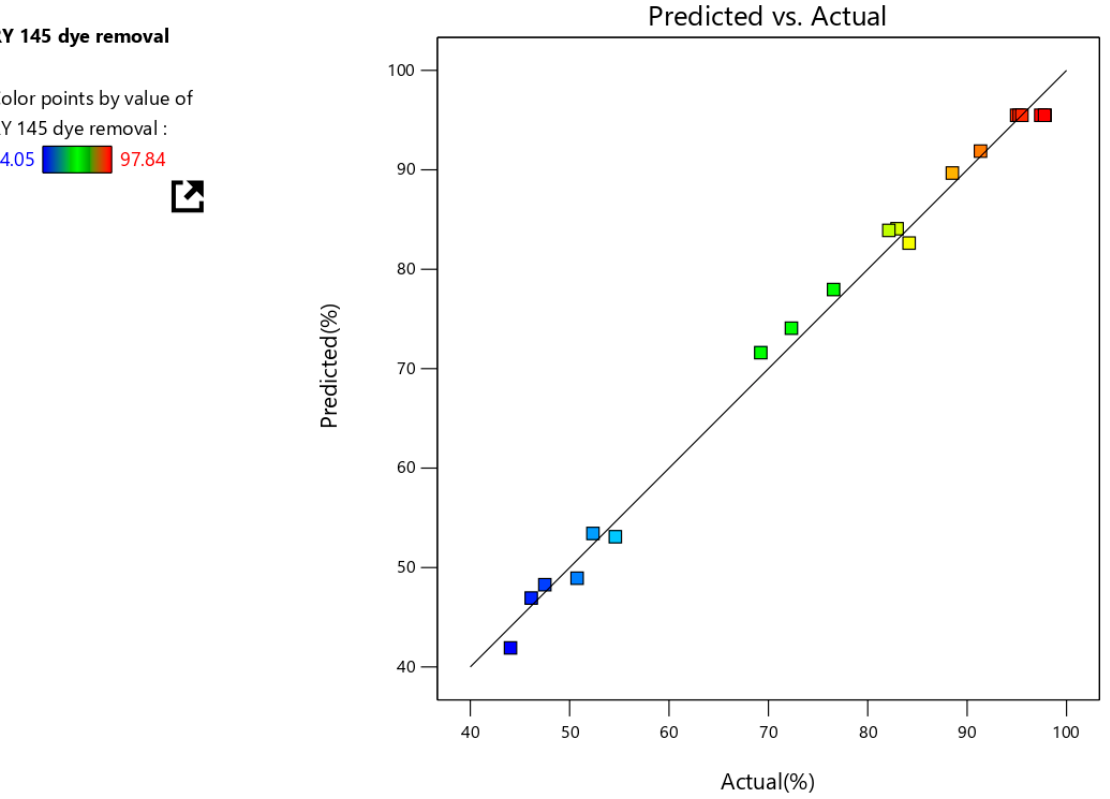
Figure 3. The graphical illustration for the actual and predicted dye removal e ffi ciency.